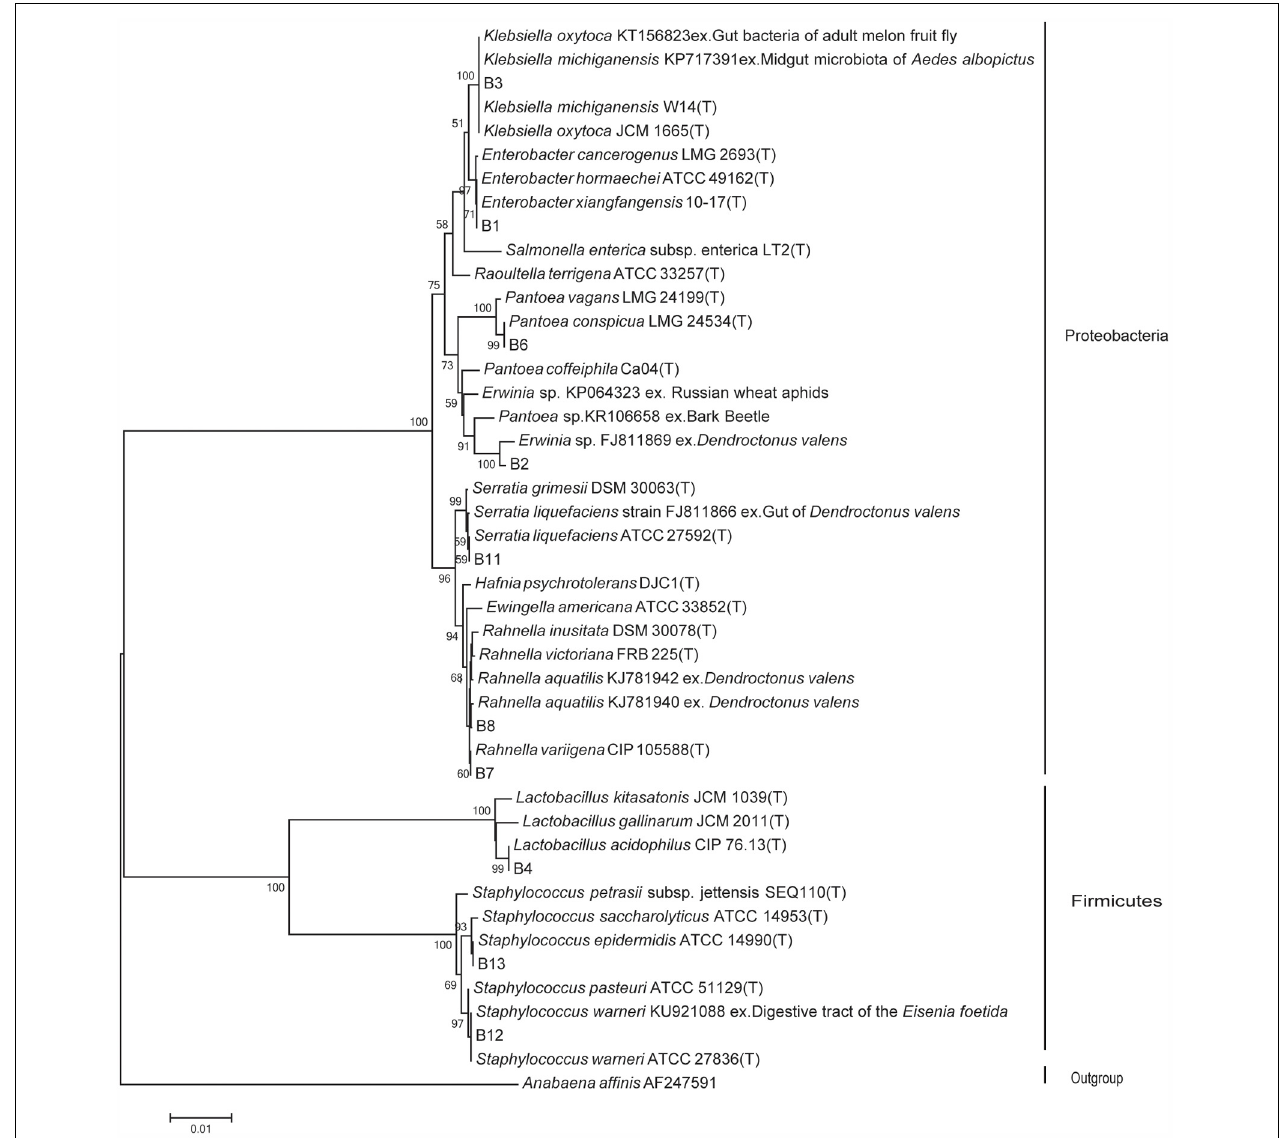
FIGURE 1 | Maximum likelihood tree for the 16S rRNA of Dendroctonus valens gut associated facultative bacteria. The ecologically related (indicated after the accession number with “ex.” as the beginning) sequences from GenBank and the types (indicated with “T”) from EzTaxon-e database. The 16S rRNA sequence of Anabaena affinis was used as outgroup. Numbers on the nodes represent bootstrap support from 1,000 replicates. Nodes with bootstrap values of 50% or more are